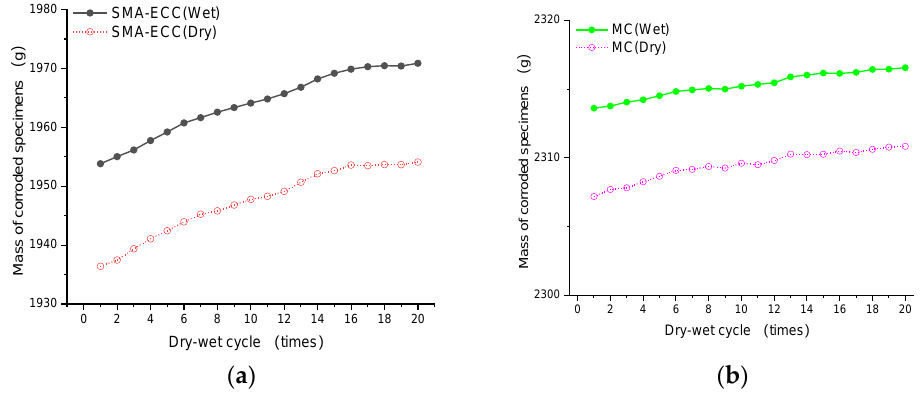
Figure 9. Mass change of corroded specimens under dry-wet cycles. ( a ) SMA-ECC ( b ) MC.